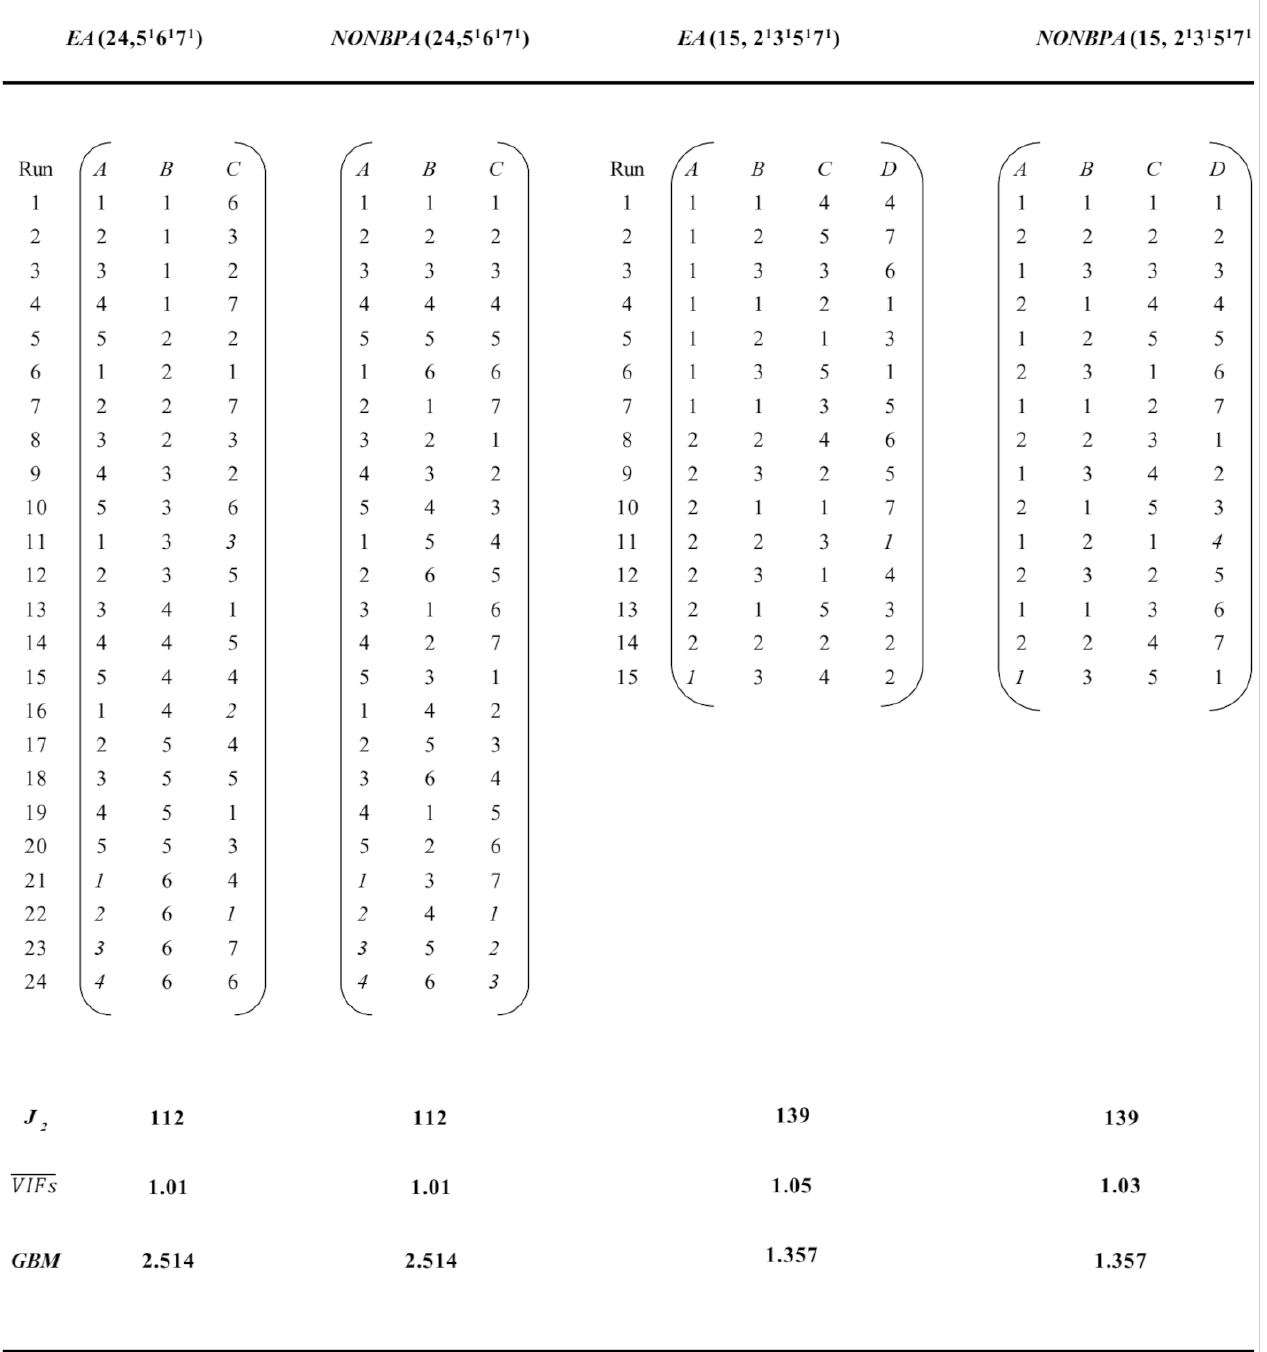
Figure 9. Comparison of EAs vs. NONBPAs for the (24,5 1 6 1 7 1 ) and (20,2 1 3 1 5 1 7 1